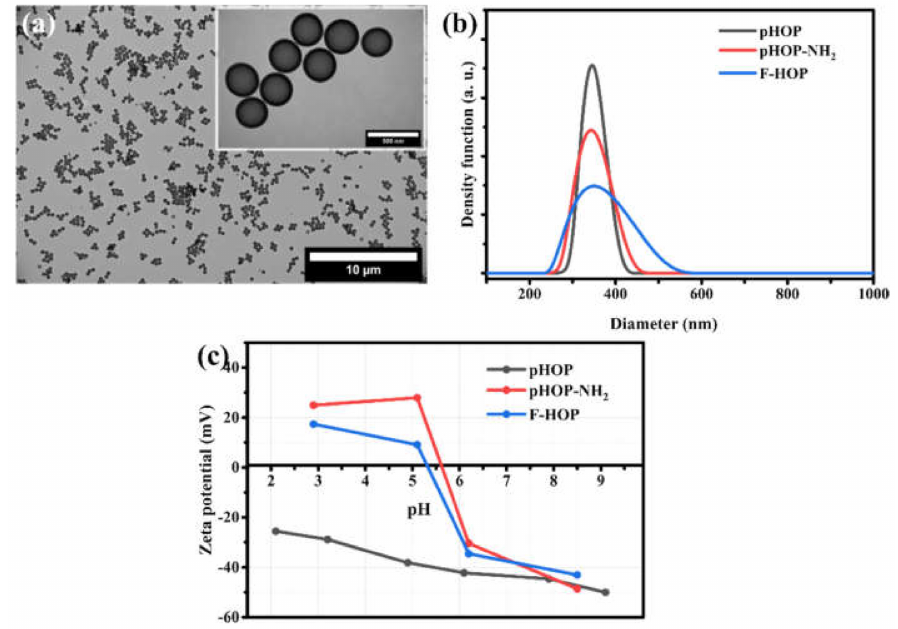
Figure 4. TEM image of F-HOPs ( a ), and size distributions by DLS ( b ) and Zeta potentials as the function of pH ( c ) of pHOP, pHOP-NH 2 , and F-HOP